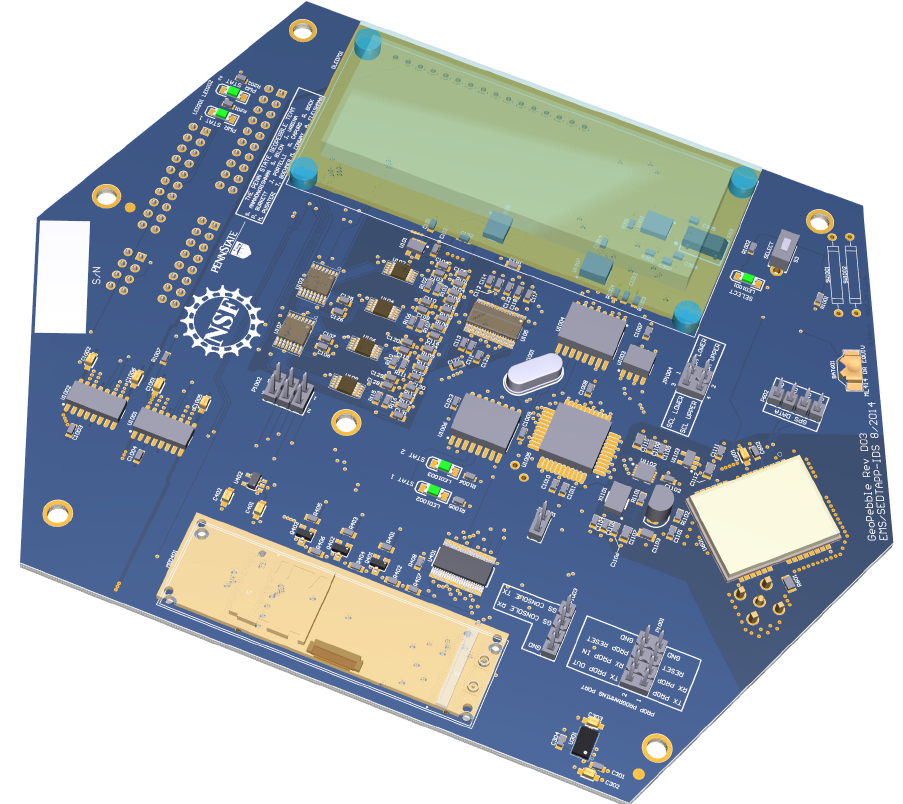
Figure 3. Primary electronics board for geoPebble